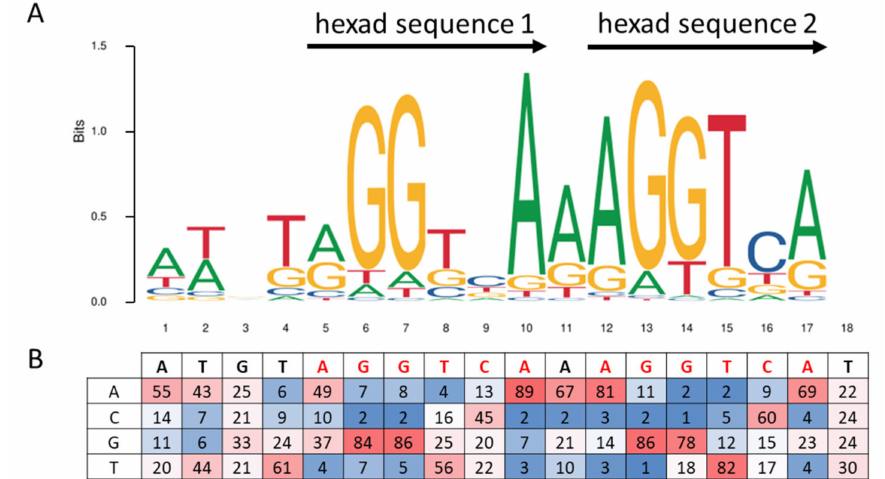
Figure 2. Sequence logo and consensus matrix of the PPAR α /RXR α PPRE consensus sequence from MA1148.1 Jaspar matrix [38]. ( A ) Sequence logo of the MA1148.1 Jaspar matrix, presenting the conservation of nucleotides from multiple alignments of 1000 PPAR α /RXR α PPRE sequences. Adenosine (A), cytidine (C), guanosine (G), and thymidine (T) nucleotides are respectively green-, blue-, yellow-, and red-colored, and the relative size of the letters represents their frequency in the consensus. The total height of a logo position corresponds to the degree of conservation in the corresponding multiple sequence alignment. ( B ) A table representing the percentage of the four bases for each position of the consensus. The color gradient code highlights the percentage of conservation of bases from blue to red for the whole